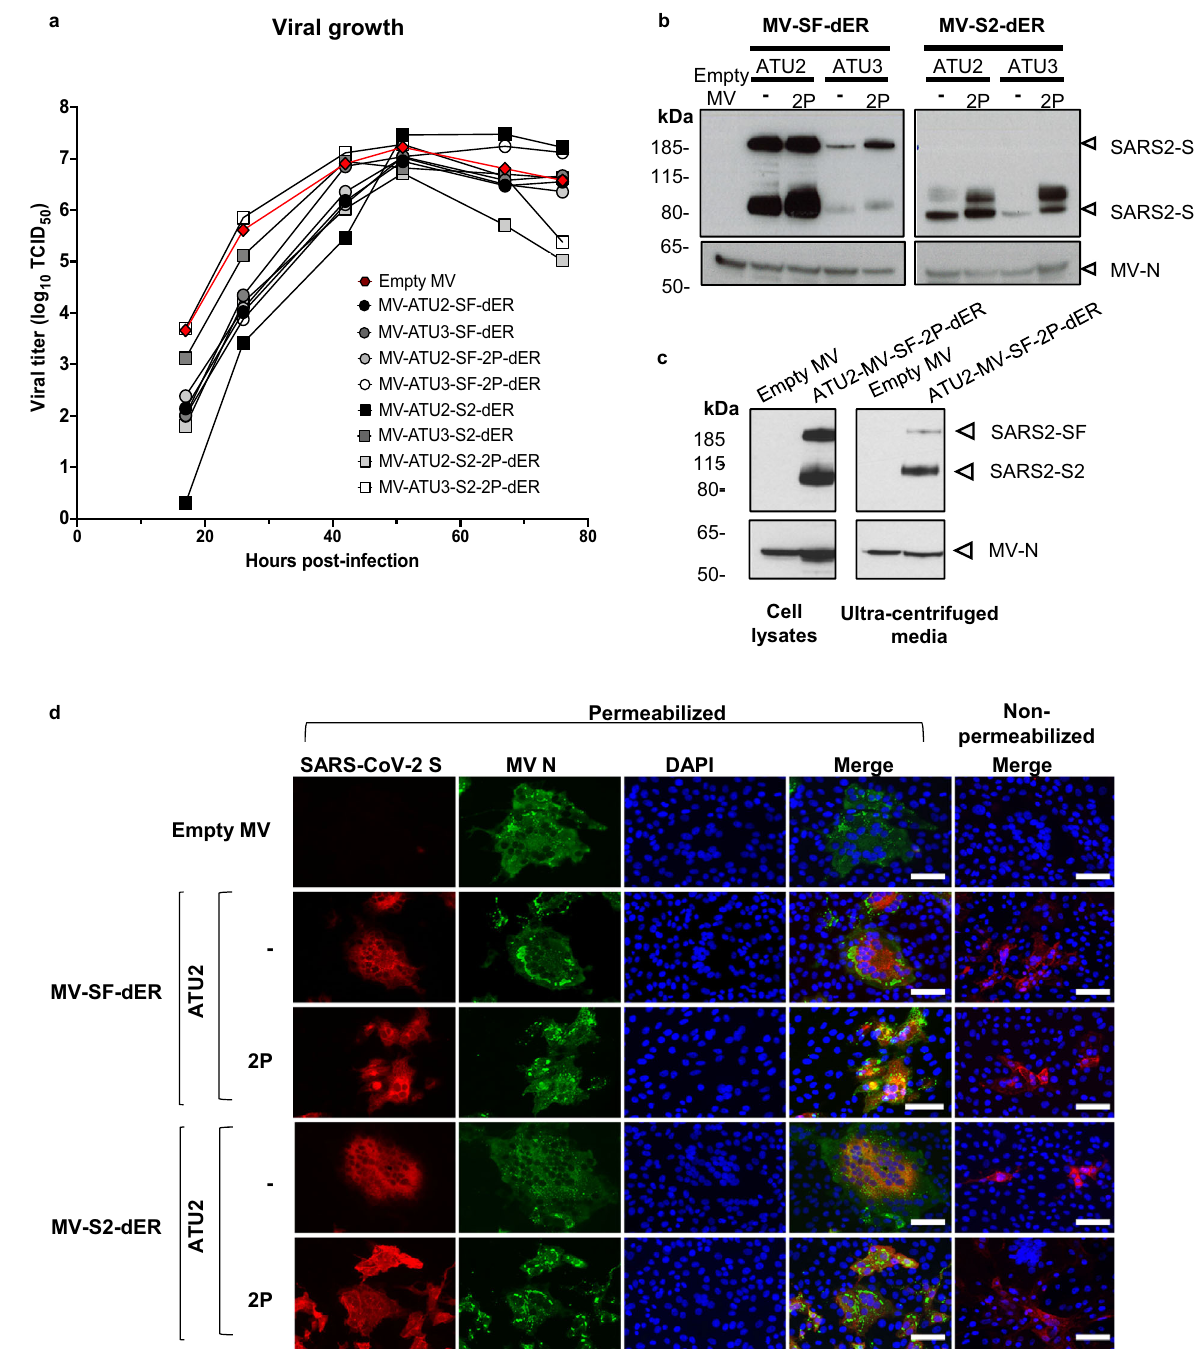
Fig. 2 Characterization of S-expressing rMVs. a Growth kinetics of rMV constructs used to infect Vero cells at an MOI of 0.1. Cell-associated virus titers are indicated in TCID 50 /ml. b Western blot analysis of SARS-CoV-2 S protein in cell lysates of Vero cells infected with the rMVs expressing SF-dER or S2- dER from either ATU2 or ATU3, with or without the 2P mutation. c Western blot analysis of ultracentrifuged media and cell lysates of Vero infected with rMV-ATU2-SF-2P-dER. d Immuno fl uorescence staining of Vero cells infected with the indicated rMVs 24 h after infection. Permeabilized or non- permeabilized cells were stained for S (red), MV N (green) and nuclei (blue); ×20 magni fi cation (scale bar, 50 µ m). The experiments shown were conducted using two or three biologically independent Vero cell